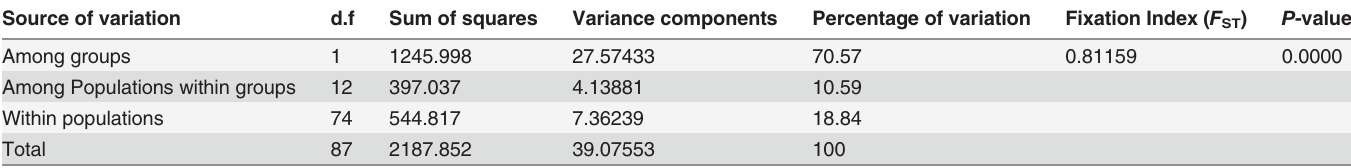
Table 2. Analysis of molecular variance (AMOVA) based on mtDNA sequences of the populations of Spirometra erinaceieuropaei . Source of